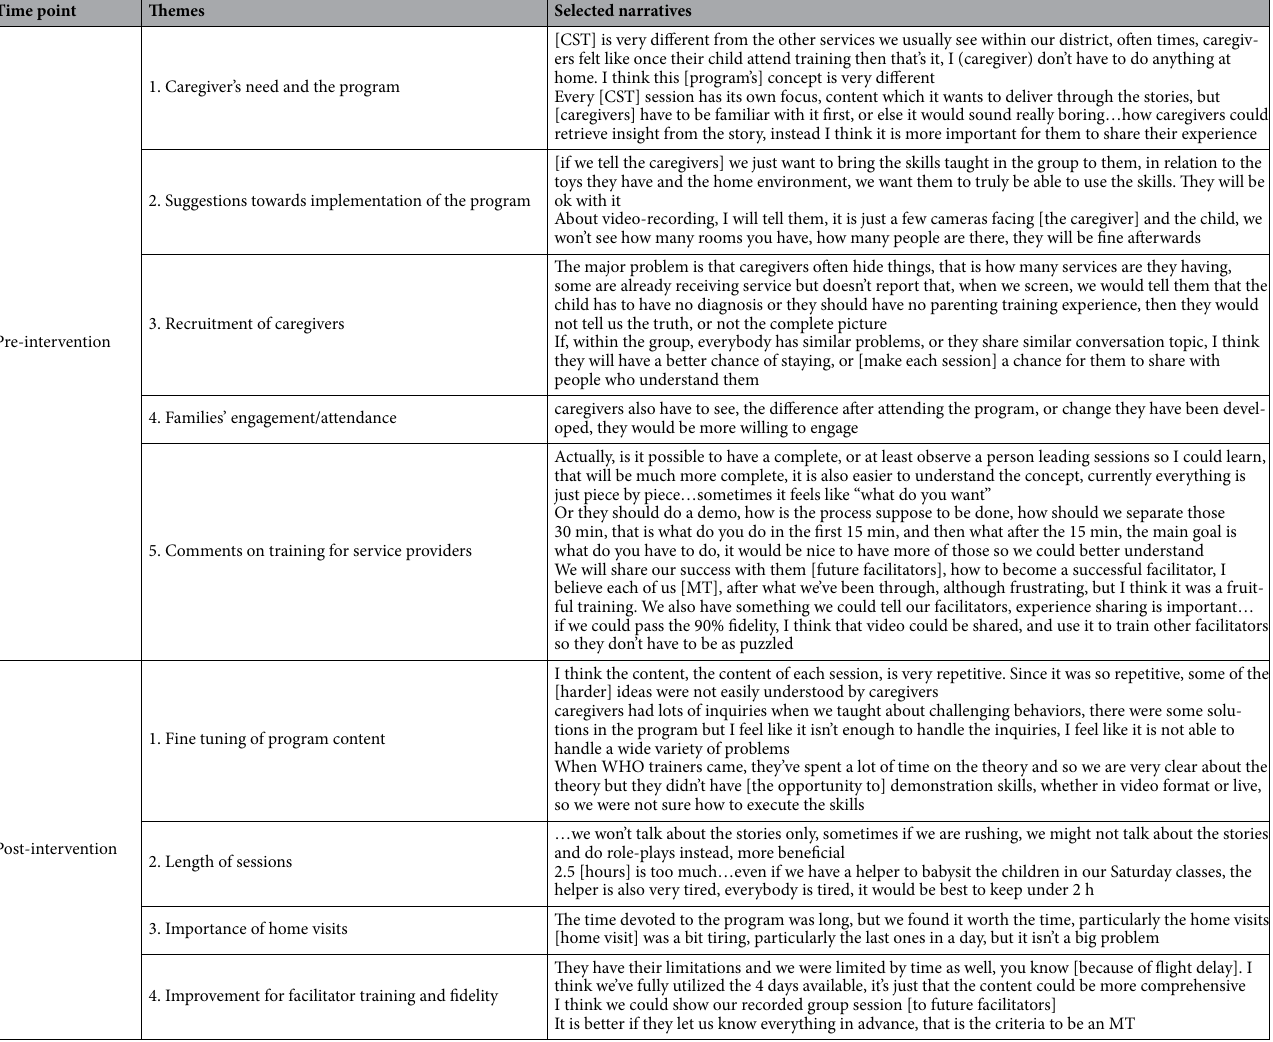
Table 6. Themes and selected narratives from pre- and post-intervention interviews with MTs in phase 2 (n =